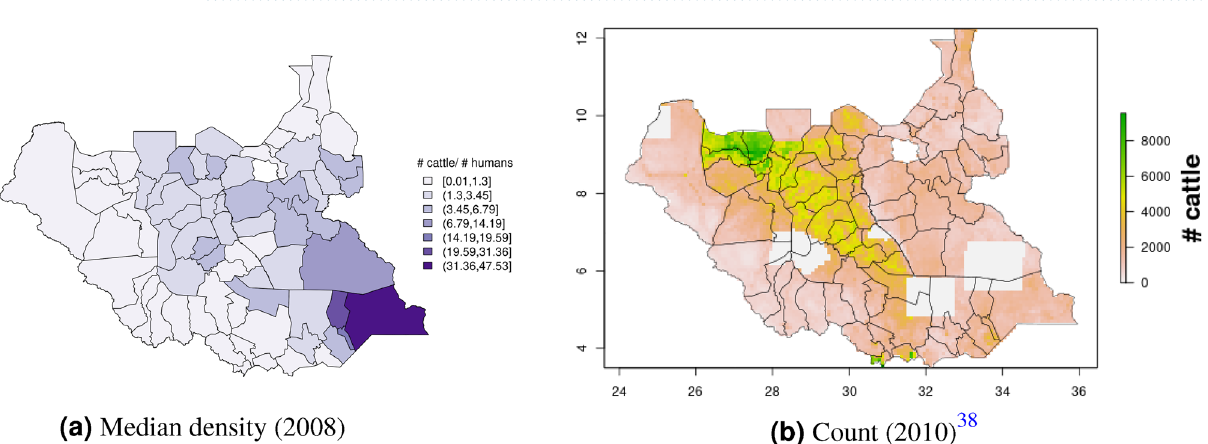
Figure 16. Cattle ( a-b ) and pig ( c-d ) density mapping results, South Sudan, 2008. Median ( a, c ) and standard error ( b, d ).